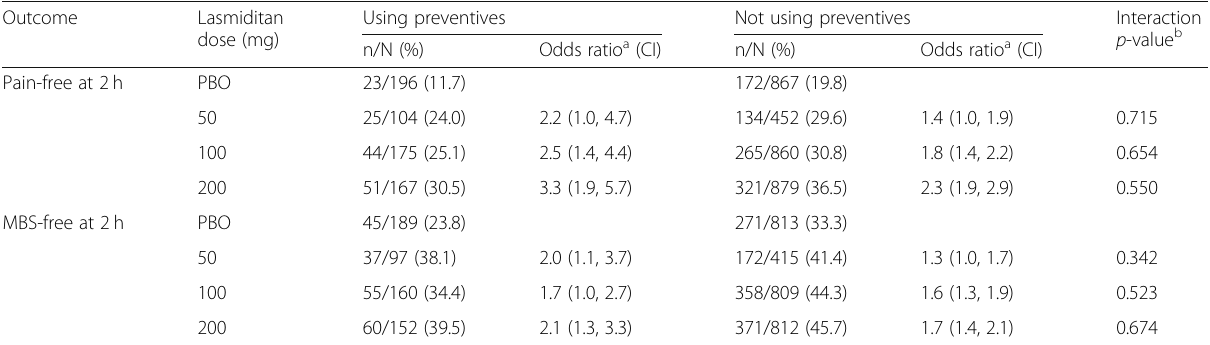
Table 3 Odds ratios for lasmiditan treatment versus placebo were similar or greater in the group of patients using preventives than in those not using preventives Outcome Lasmiditan Using preventives dose (mg)